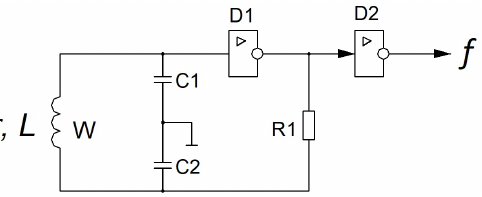
Figure 2. Structure of eddy-current probe with self-oscillating